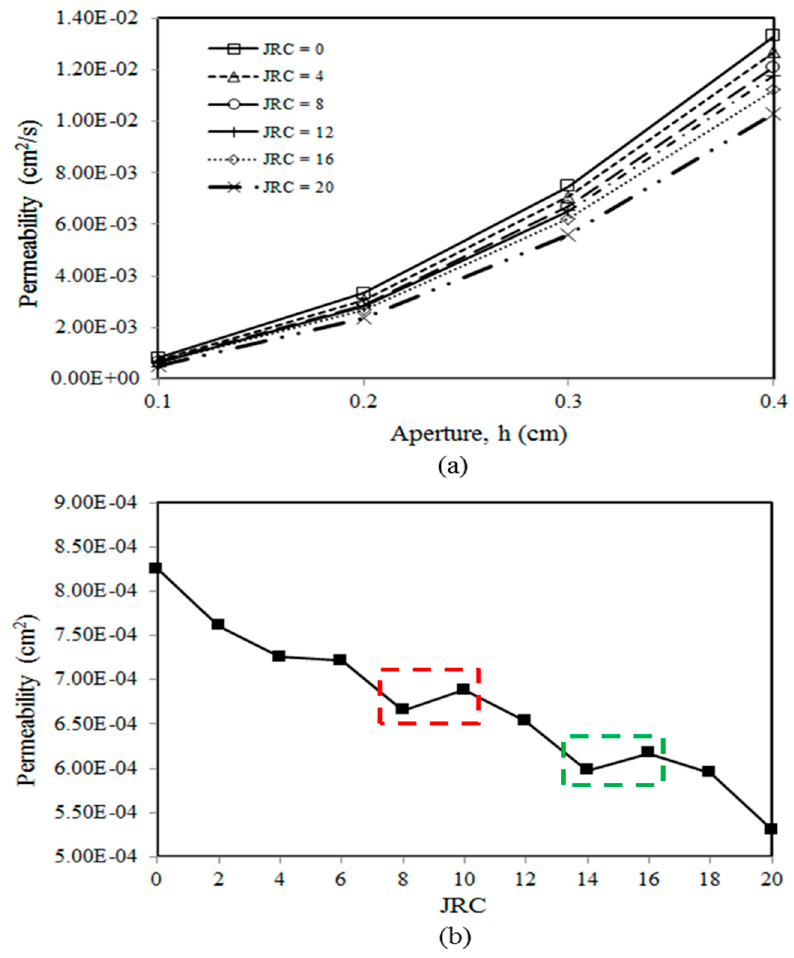
Figure 6. The relationship between the JRC, aperture and permeability: ( a ) the relationship between permeability and the JRC; ( b ) the relationship between the correction factor and the JRC.